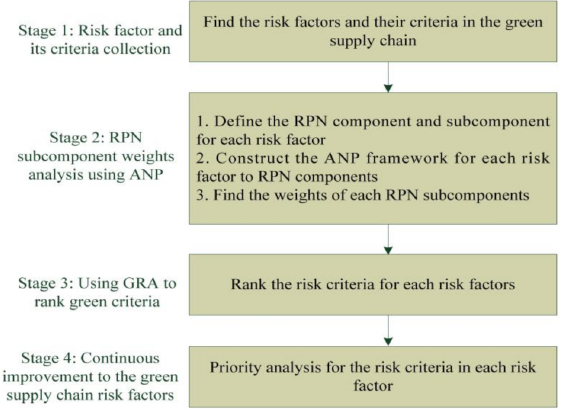
Figure 1. The framework of the proposed